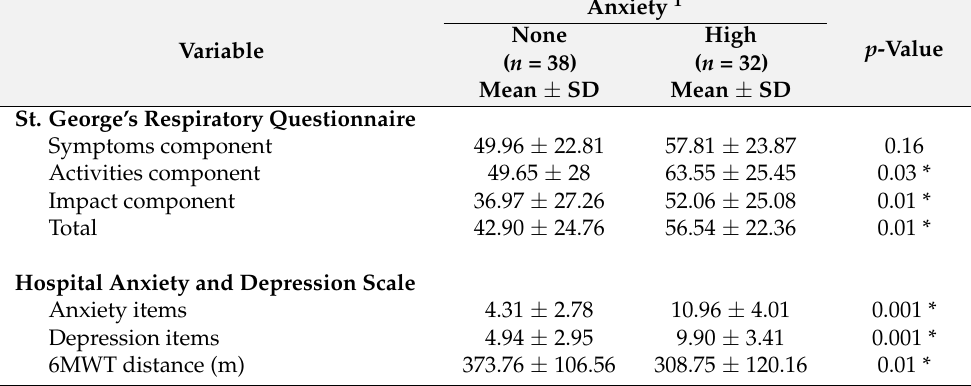
Table 2. Comparison of functional performance and psychological outcomes between patients with no anxiety and patients with high anxiety levels ( n =